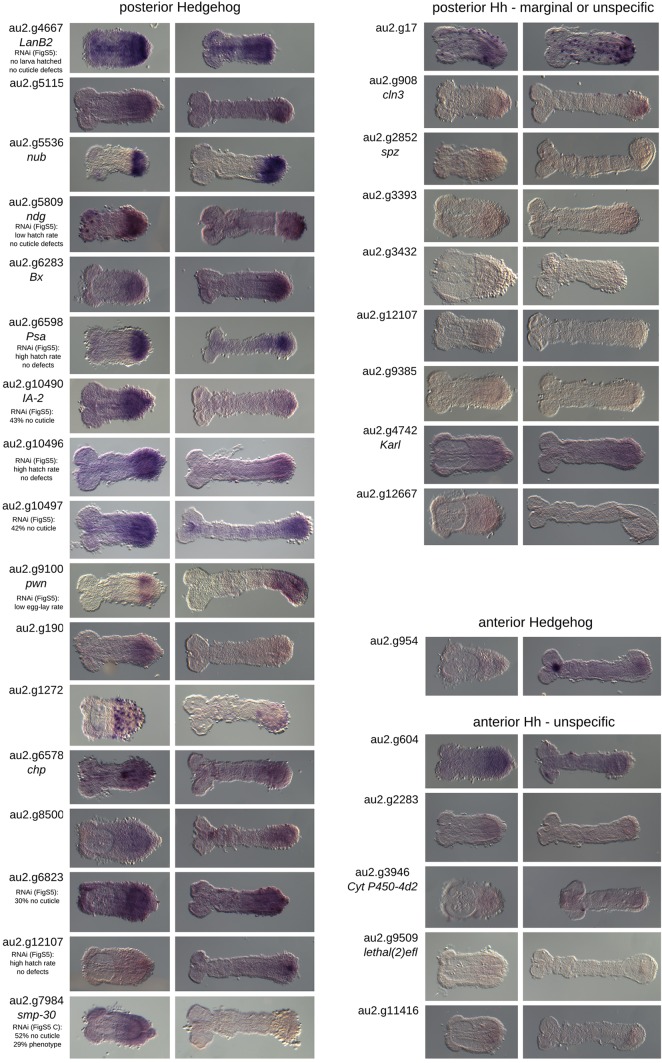
In situ hybridizations of candidate Hh targets. Posterior Hh candidates: 27 genes were selected for the in situ screen, including 12 with a homologous gene in Drosophila and 15 without. Among the genes with a homolog, nine showed posterior expression. In the group of unknown genes, eight were expressed in posterior regions. In summary, we looked at 27 genes with 17 showing posterior expression (63%). Anterior Hh candidates: this set contains eight genes. Three had a homologous gene in Drosophila. We used seven in the in situ screen with only one showing anterior expression.